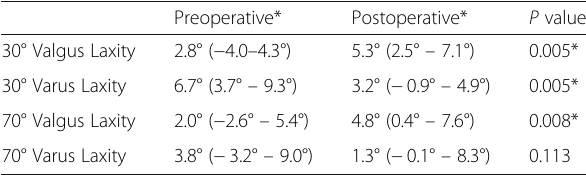
Table 1 Differences in varus and valgus laxity in 30° and 70° flexion of the